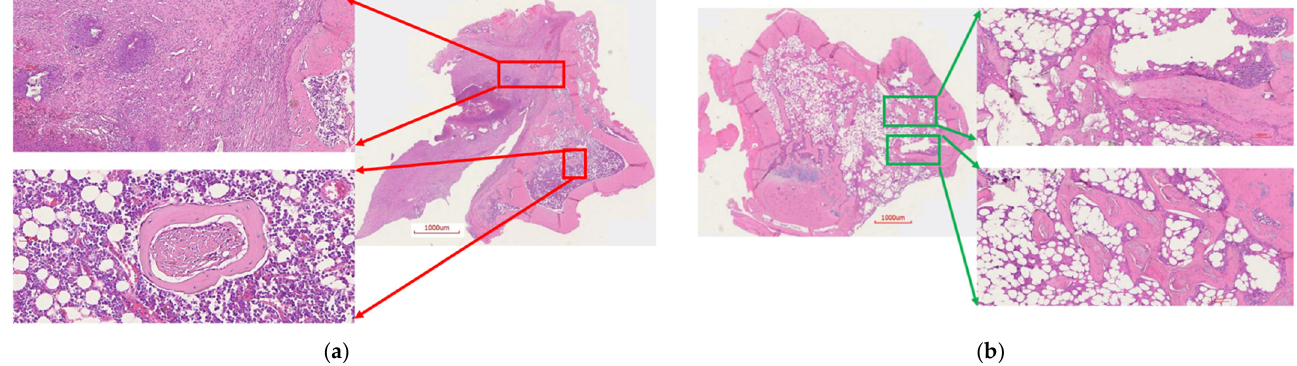
Figure 13. H&E staining of rat bone. ( a ) Control rat bone. Note that there was growth with narrowing of the marrow space. Additionally, there were places of bone thickening and a large fibrous capsule with inflammatory cells; ( b ) Bone from the treatment group rat showed ongoing healing of the bone, including new bone formation in the defect. Osseointegratation of the host bone was seen, as the degradation of the ABVF-BG allowed new bone in-growth.